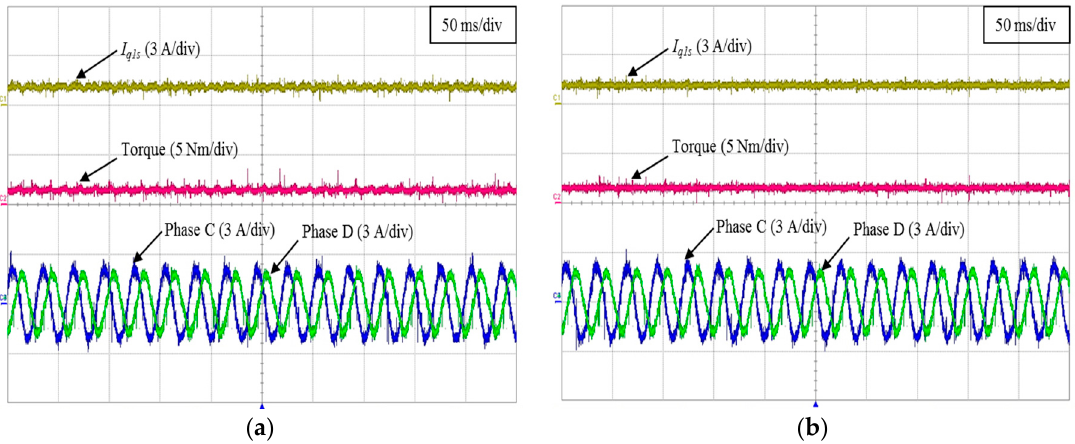
Figure 18. Experimental result of fault ‐ tolerance under open fault phases B in i q1s = 1 A and 1000 rpm: ( a ) Without tolerant control; ( b ) With tolerant control.